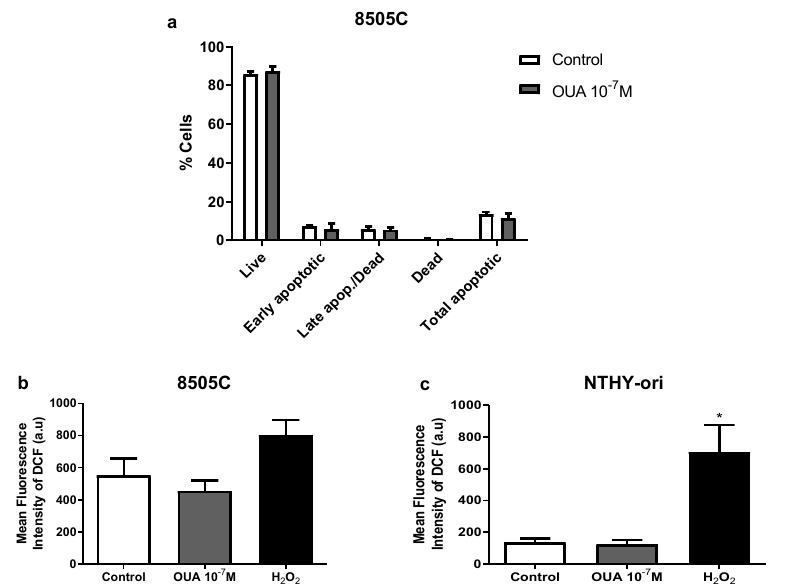
Figure 2. Ouabain did not increase 8505 death or ROS levels. 8505C and NTHY-ori cells were cultured for 24 h with 10 − 7 M of ouabain or left untreated. ( a ) 8505C death was analyzed using Muse Annexin V & Dead Cell Kit (n = 3). Data are expressed as the mean percentage of live, early apoptotic, late apoptotic/dead and total apoptotic cells ± SEM in ouabain-treated and control cultures. ( b , c ) 8505C and NTHY-ori intracellular ROS levels (CM-H2DCFDA fluorescence) were evaluated with flow cytometry (n = 6). Data are expressed as the mean fluorescence intensity of DCF in 8505C ( b ) and NTHY-ori ( c ) cells. * p < 0.05 using repeated measures ANOVA with Dunnett´s post-test.